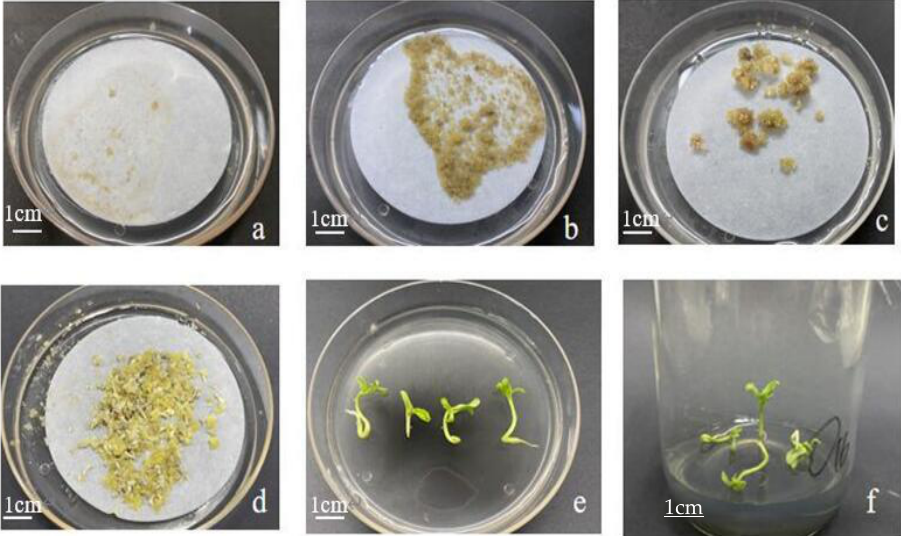
Figure 6. Recovery culture process of embryonic callus of F. mandshurica after cryopreservation by the slow cooling method. ( a , b ) F. mandshurica embryonic callus at day 1 and day 30 of culture; ( c ) somatic embryo callus differentiation; ( d ) somatic embryo maturation culture; ( e ) germination of the somatic embryos of F. mandshurica and the appearance of roots; ( f ) F. mandshurica emblings.